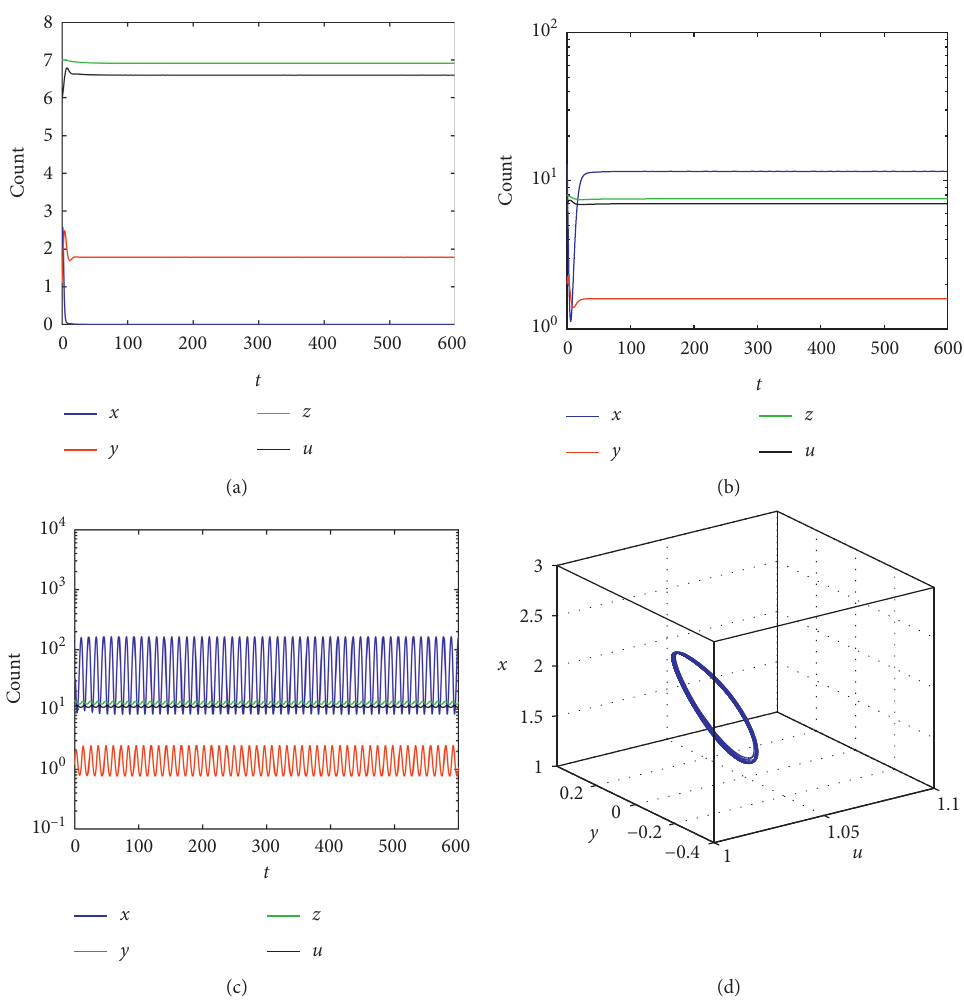
( 0 , 1 . 782 , 6 . 909 , 6 . 596 ) is LAS. (b) When 0